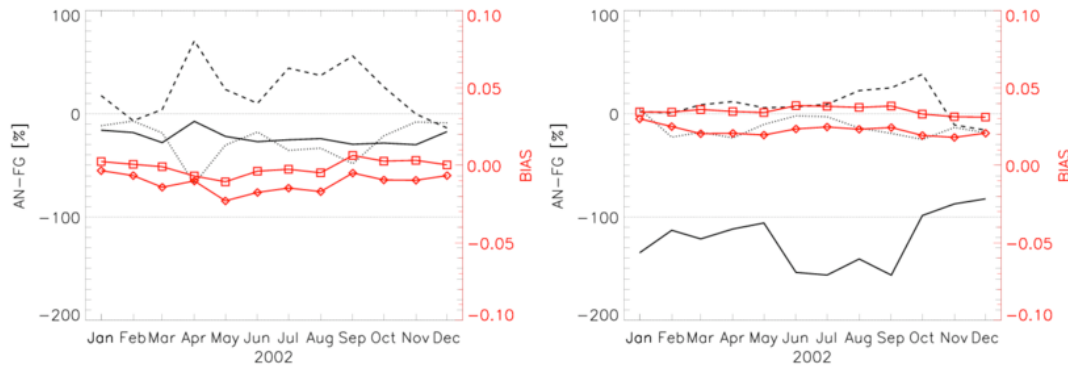
Figure 7. Fig. 7. Total (left) and fine mode AOD (right) change in root mean square error (black dotted), mean bias (black continuous) and correlation coefficient (black dashed) between analysis and MODIS AOD and between first guess and MODIS AOD. In addition, bias for first guess (red diamond) and analysis (red square) with respect to MODIS AOD are